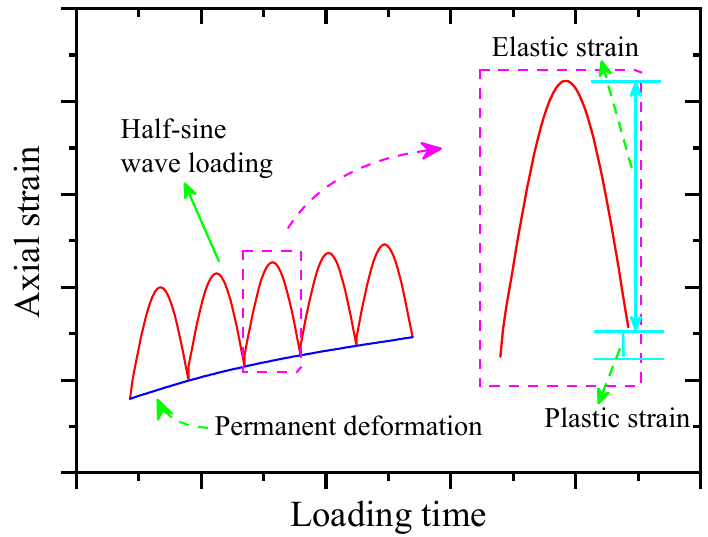
Figure 7. Schematic diagram of the permanent deformation calculation.